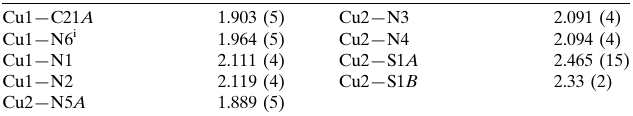
Selected bond lengths (A˚